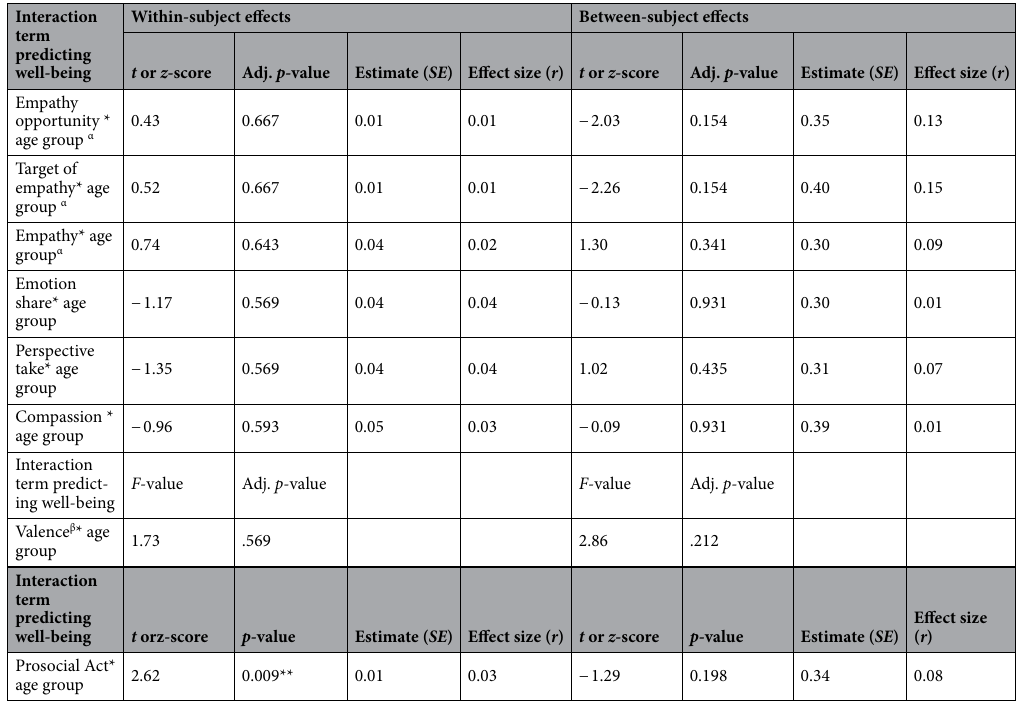
Table 2. Within- and between person effects of different interactions regarding different aspects of daily empathy and age predicting daily well-being. Well-being was included in all models as continuous outcome variable. Statistics obtained from mixed models, nested within participant and survey day. Each interaction ran in a separate model, with age as linear and quadratic term separately. Model selection was conducted based on a loglikelihood ratio test. P-values were adjusted to control the false discovery rate. ** p < 0.01. α Between- subjects effect models include religiosity as covariate. β Positive, negative, or neutral target